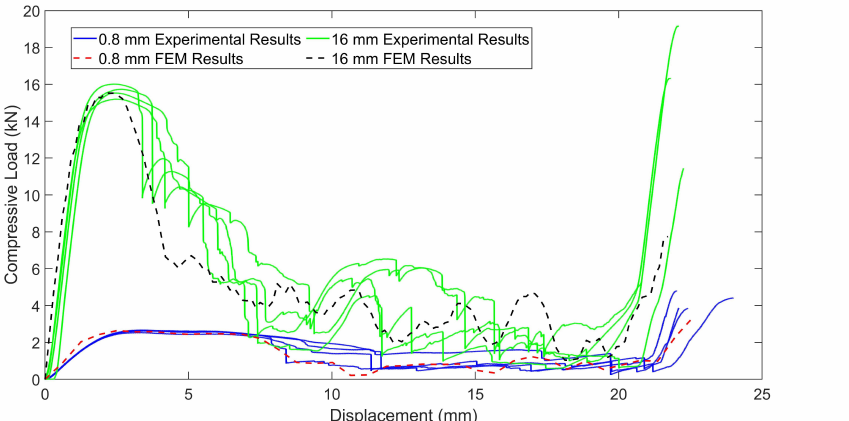
Figure 17. Experimental and numerical results for the crushing of chiral units with 0.8 mm and 1.6 mm